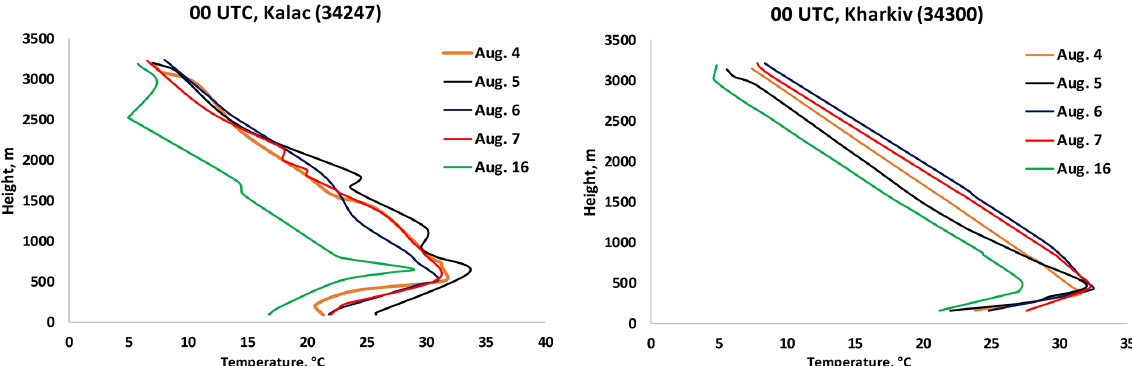
Figure A2. The air temperature vertical profiles from the vertical sounding stations Kalac and Kharkiv for selected dates (4–7 and 16 Au- gust 2010), with the deepest surface temperature inversions at nighttime